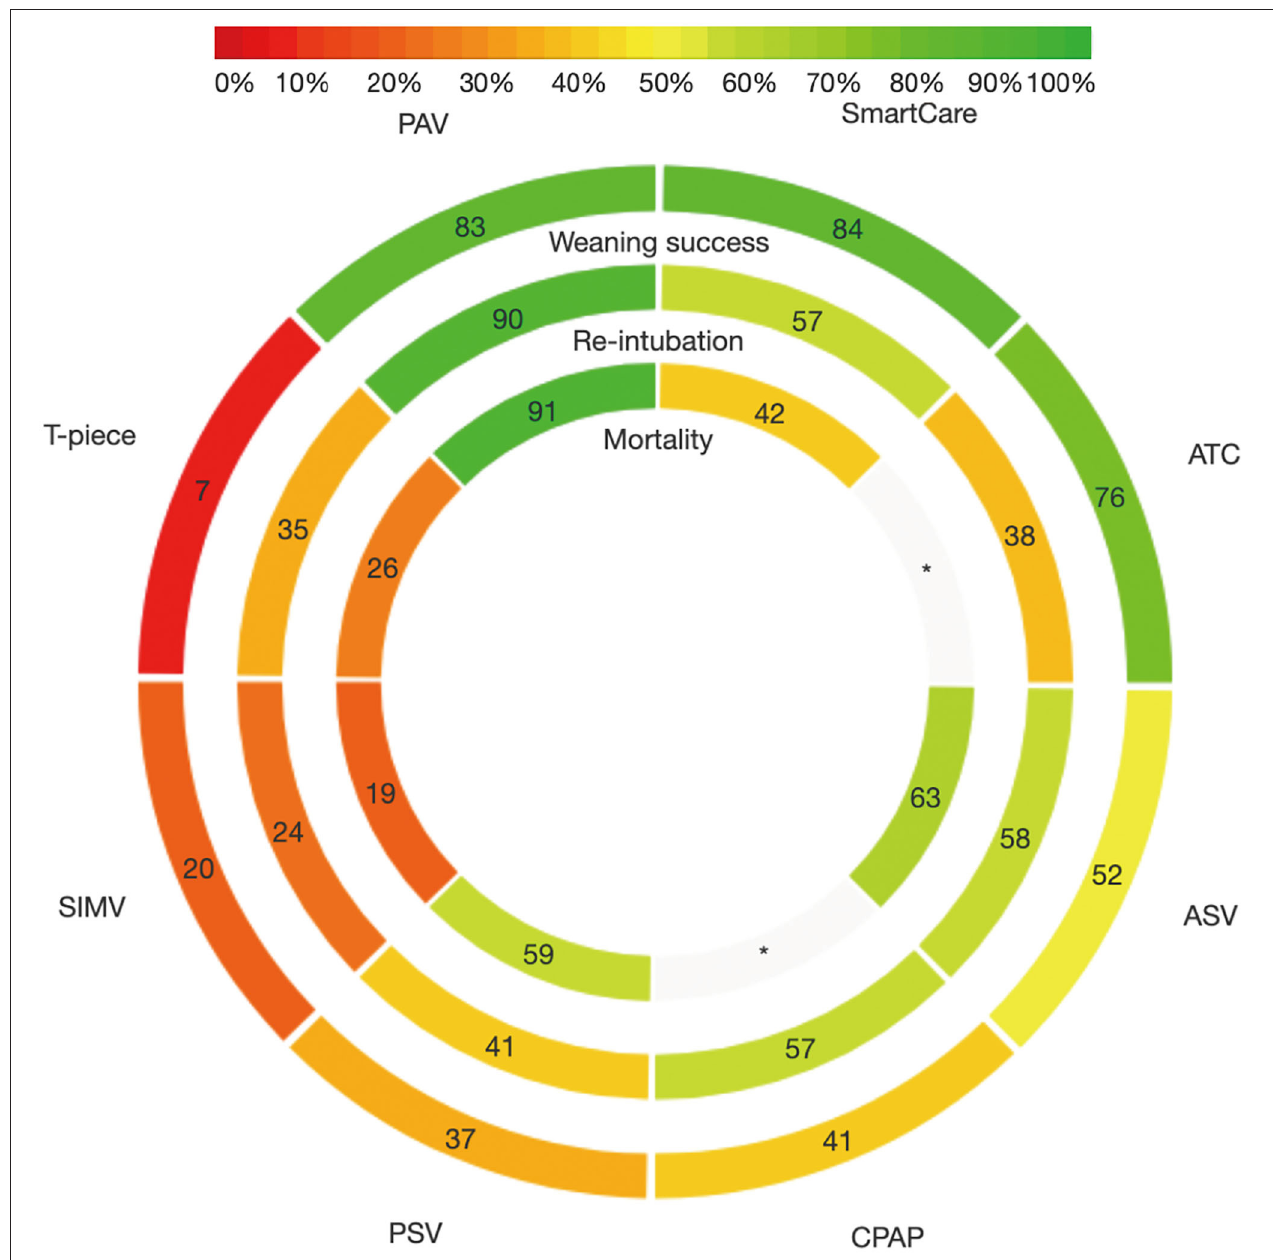
FIGURE 4 | Rank-heat plot of P -score values among different ventilator modes targeting outcomes of weaning success, proportion requiring reintubation and mortality. ASV, Adaptive support ventilation; ATC, Automatic tube compensation; CPAP, Continuous positive airway pressure; PAV, Proportional assist ventilation; PSV, Pressure support ventilation; SIMV, Synchronized intermittent mandatory ventilation; OR, odds ratio; CI, confidence